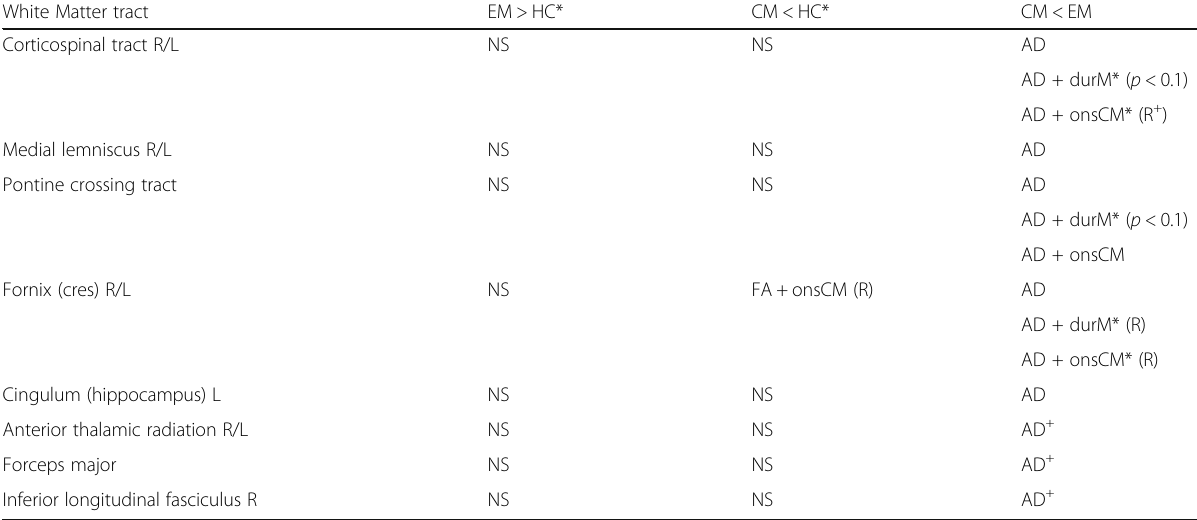
Table 6 Summary of white matter regions where significant differences were found in all comparisons (Continued)